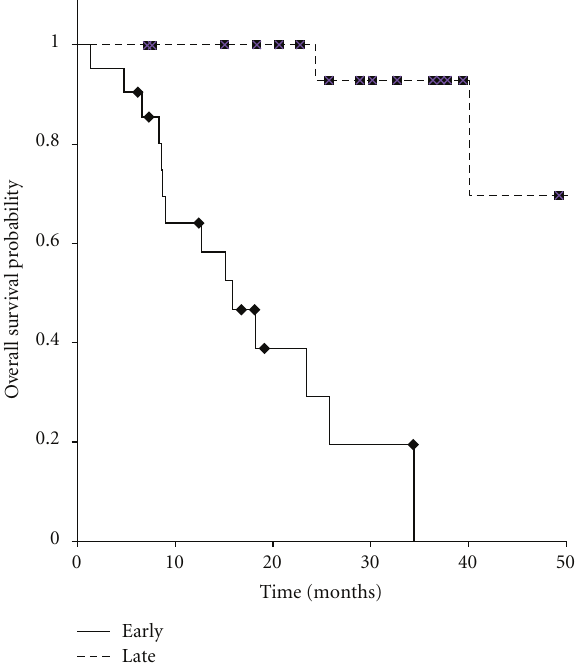
Figure 5: Kaplan-Meier curves for overall survival in 42 patients with oligo-recurrence cancer in the lung, early recurrence group versus late recurrence